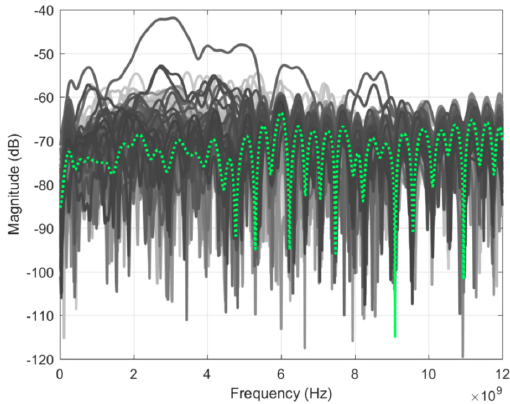
Figure 6. Residual noise for 140 antenna positions after the subtraction of two identical scans of the empty tank. Average value in dotted green.